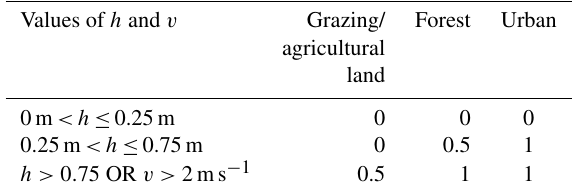
Table 4. The Debris Factor (DF) for different water heights ( h ), flow velocities ( v ) and land uses. Source: ISPRA (2012), with reference to DEFRA and UK Environment Agency (2006). Values of h and